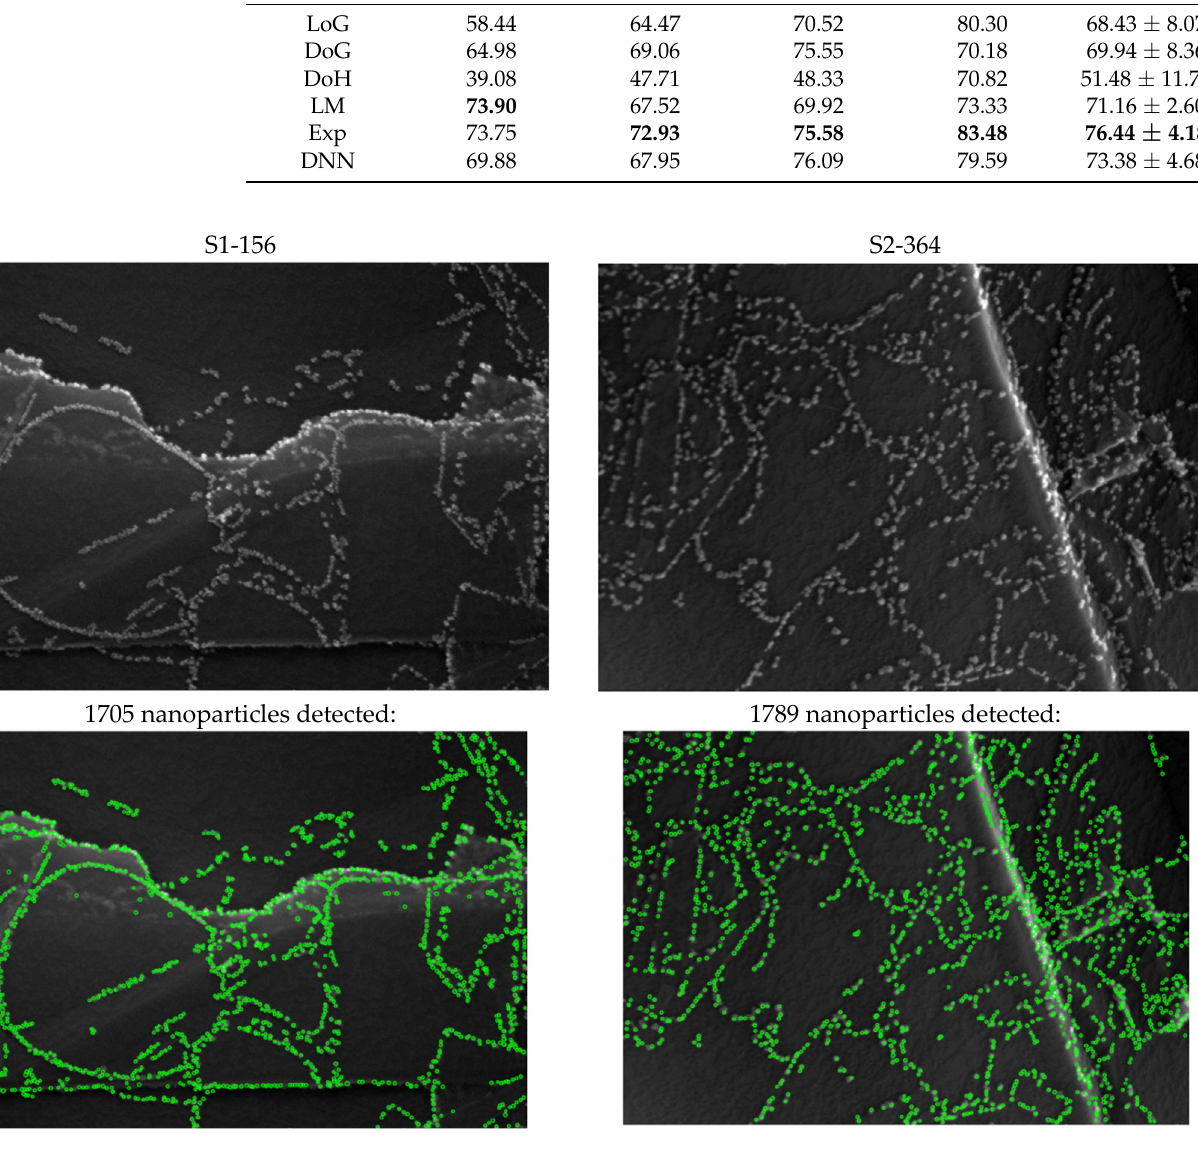
Figure 2. Examples of images of types S1 ( left ) and S2 ( right ) from the base and the results of nanoparticle